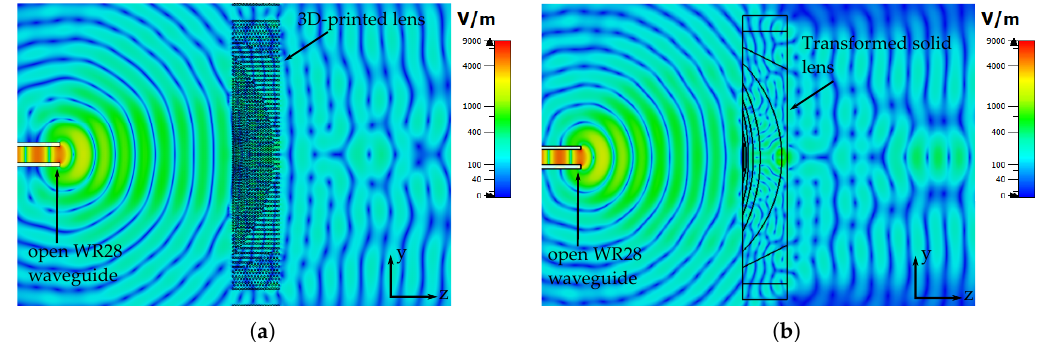
Figure 10. Simulated electric field at 30 GHz ( a ) Transformed 3D-printed lens. ( b ) Transformed solid